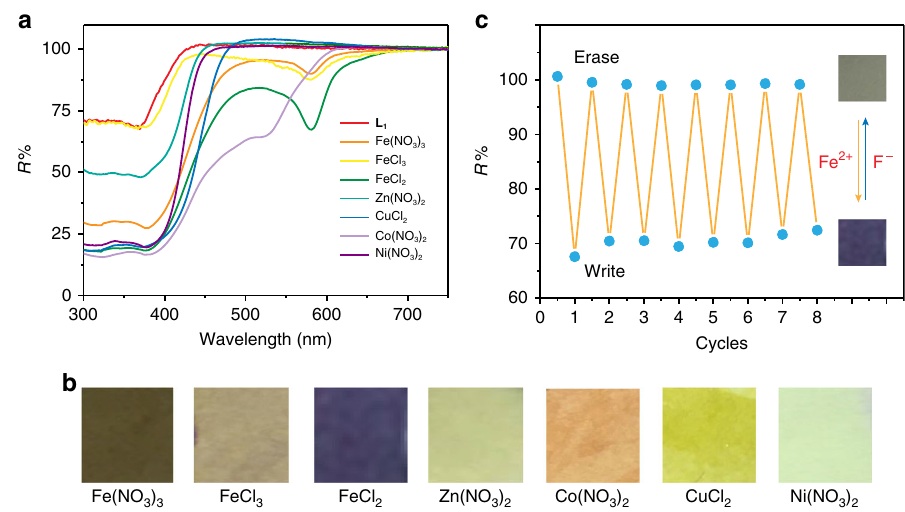
Fig. 2 Multicolour and reversibility of rewritable paper. a The re fl ective UV – visible spectra of rewritable paper constructed with L 1 after addition of Fe (NO 3 ) 3 , FeCl 3 , FeCl 2 , Ni(NO 3 ) 2 , Co(NO 3 ) 2 , CuCl 2 and Zn(NO 3 ) 2 , respectively. b The photographs of rewritable paper produced by addition of different metal salts. c A plot of the re fl ectivity at 577 nm vs. the number of cycles as the rewritable paper is cycled through FeCl 2 aqueous solution spraying (writing) and rinsing the rewritable paper with CH 2 Cl 2 solution of TBAF